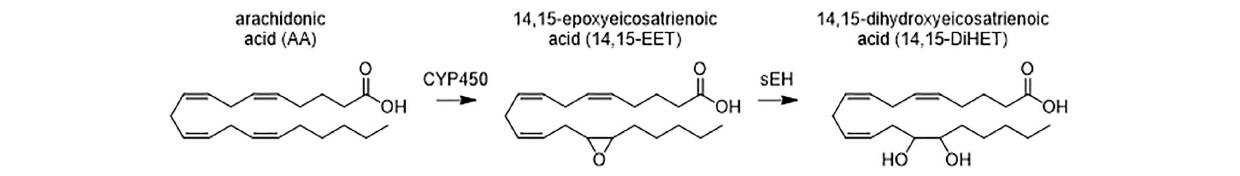
Solubility of sEHI